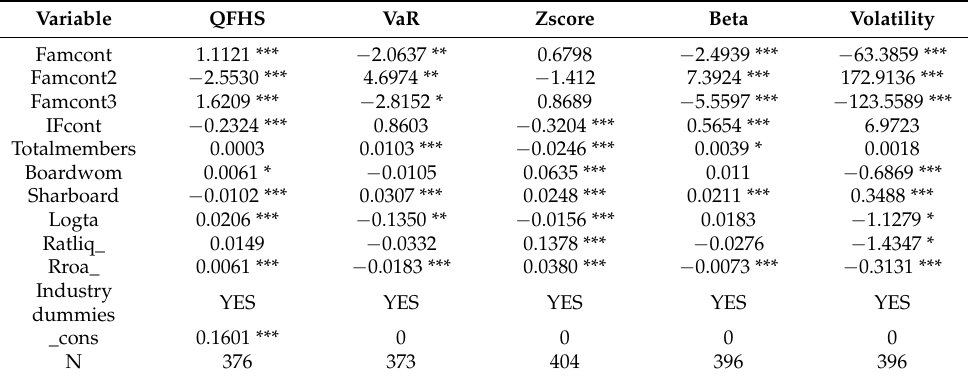
Table 14. Estimations using Driscoll and Kraay’s (1998)